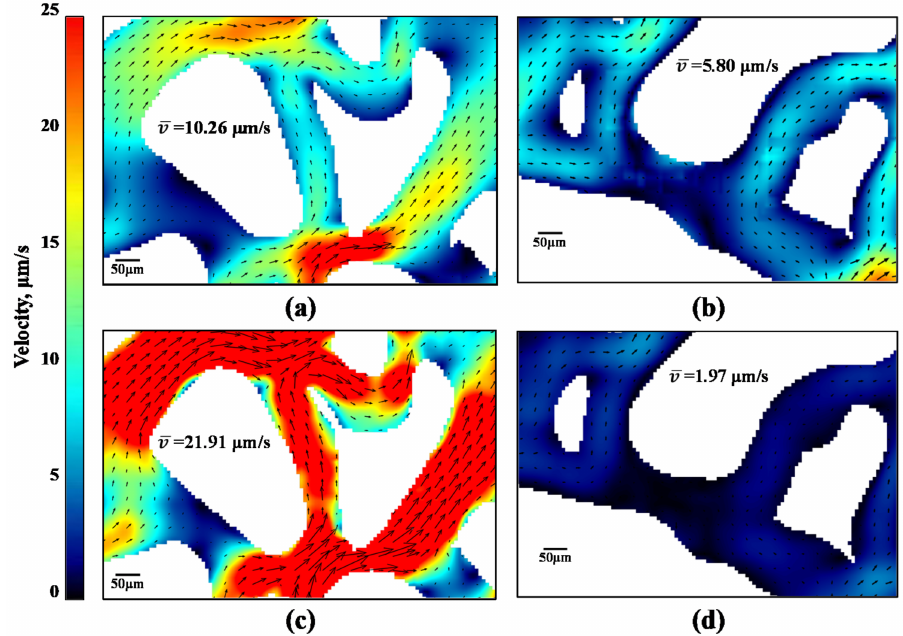
Figure 7. Velocity fields during polymer flooding with sulfide at the main stream ( a ) and margin ( b ) and during post-water flooding with sulfide at the main stream ( c ) and margin ( d